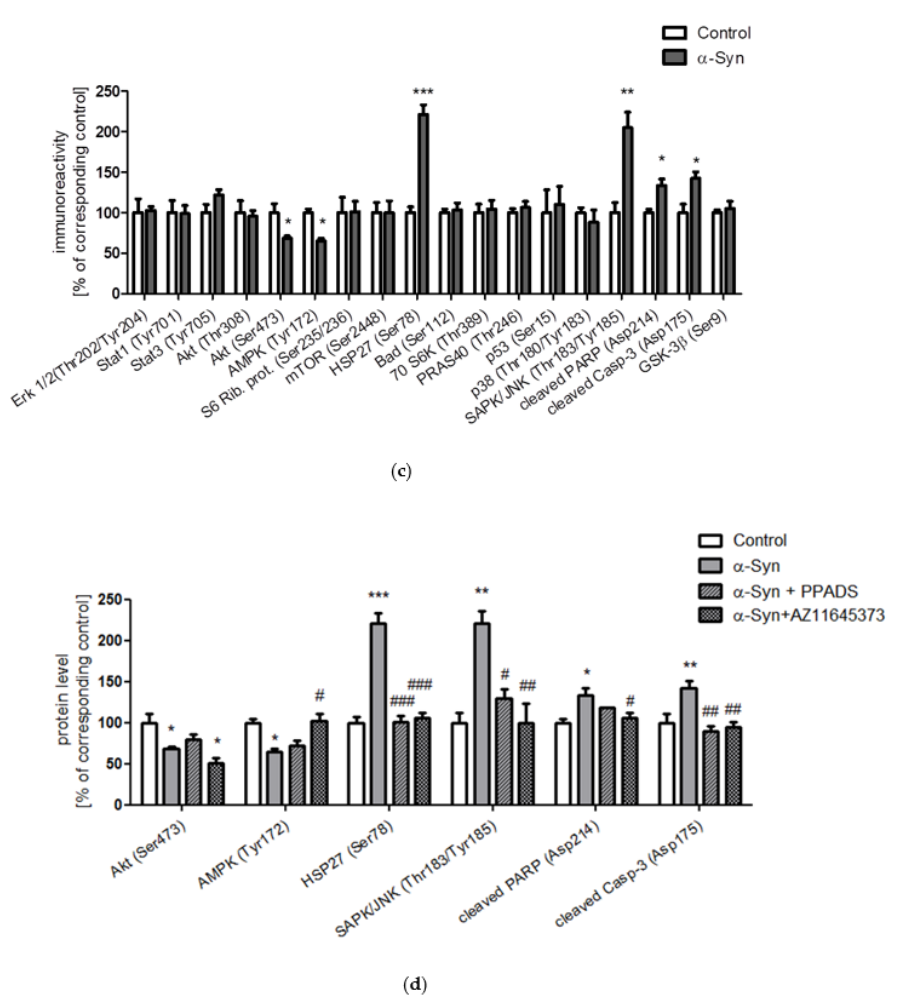
Figure 1. P2X7R simulation induces activation of molecular pathways of cell death in SH-SY5Y cells. ( a ) The effect of α -Syn and ATP on SH-SY5Y cells viability. SH-SY5Y cell viability after 48 h treatment with 10 µ M α -Syn or 1 mM ATP in the presence of 100 µ M PPADS or 10 µ M AZ 11645373 measured by 2-(4,5-dimethylthiazol-2-yl)-2,5-diphenyltetrazolium bromide (MTT) test. Data represent the mean value ± S.E.M. for four independent experiments. ** p < 0.01, *** p < 0.001 compared to control; # p < 0.05, ## p < 0.01 compared to α -Syn, and & p < 0.05, &&& p < 0.001 compared to ATP using